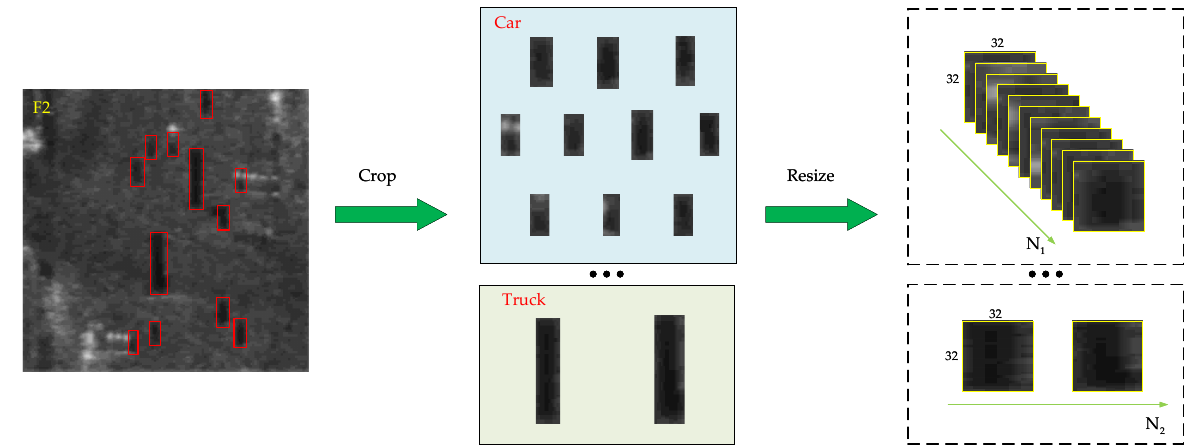
Figure 11. The process of image cropping and resizing for